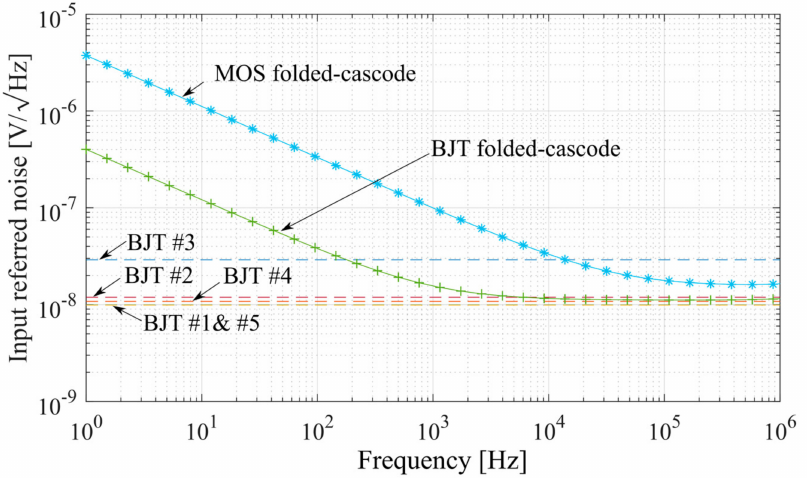
Figure 9. IRN comparison of simulated folded-cascode amplifiers with CMOS and BJT input devices. The total bias current is 20 µ A. As a reference the measured noise floor of the lateral BJTs from Table 2 are marked as dashed